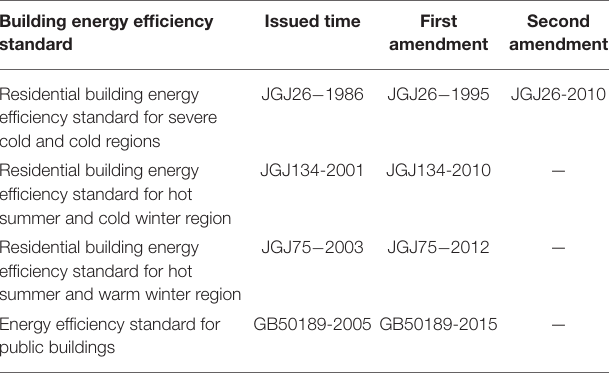
TABLE 1 | Legislations and amendments for major building energy efficiency